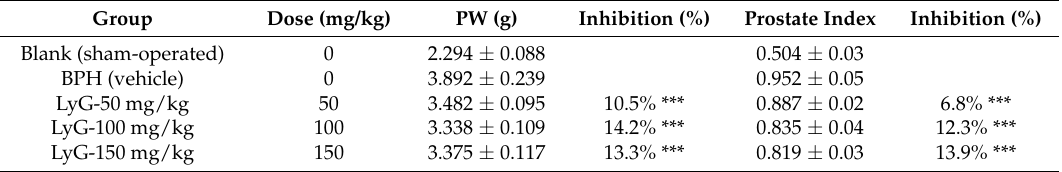
Table 1. Effect of Lycogen TM (LyG) products on prostate enlargements in testosterone induced rats.